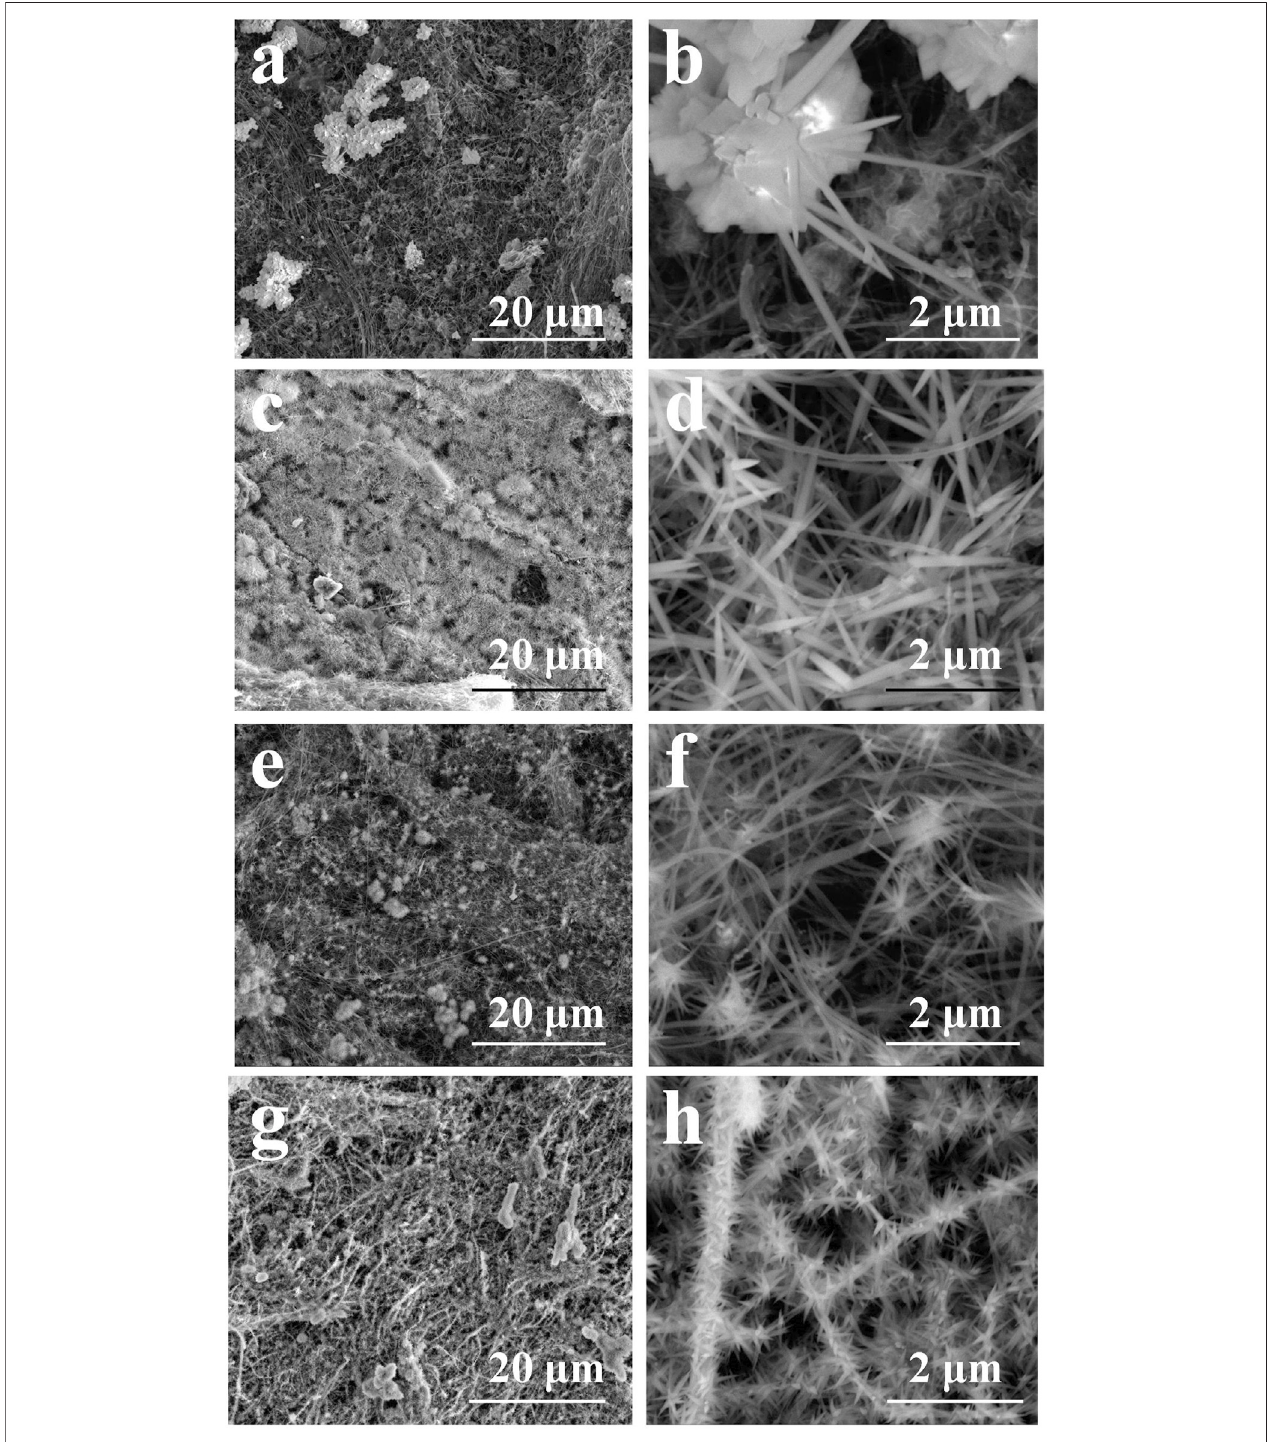
FIGURE 2 | The morphologies of Co/Ni basic carbonate nanowires on CNT network: Co (A, B) ; Co2Ni (C, D) ; CoNi (E, F) ; CoNi2 (G, H) .